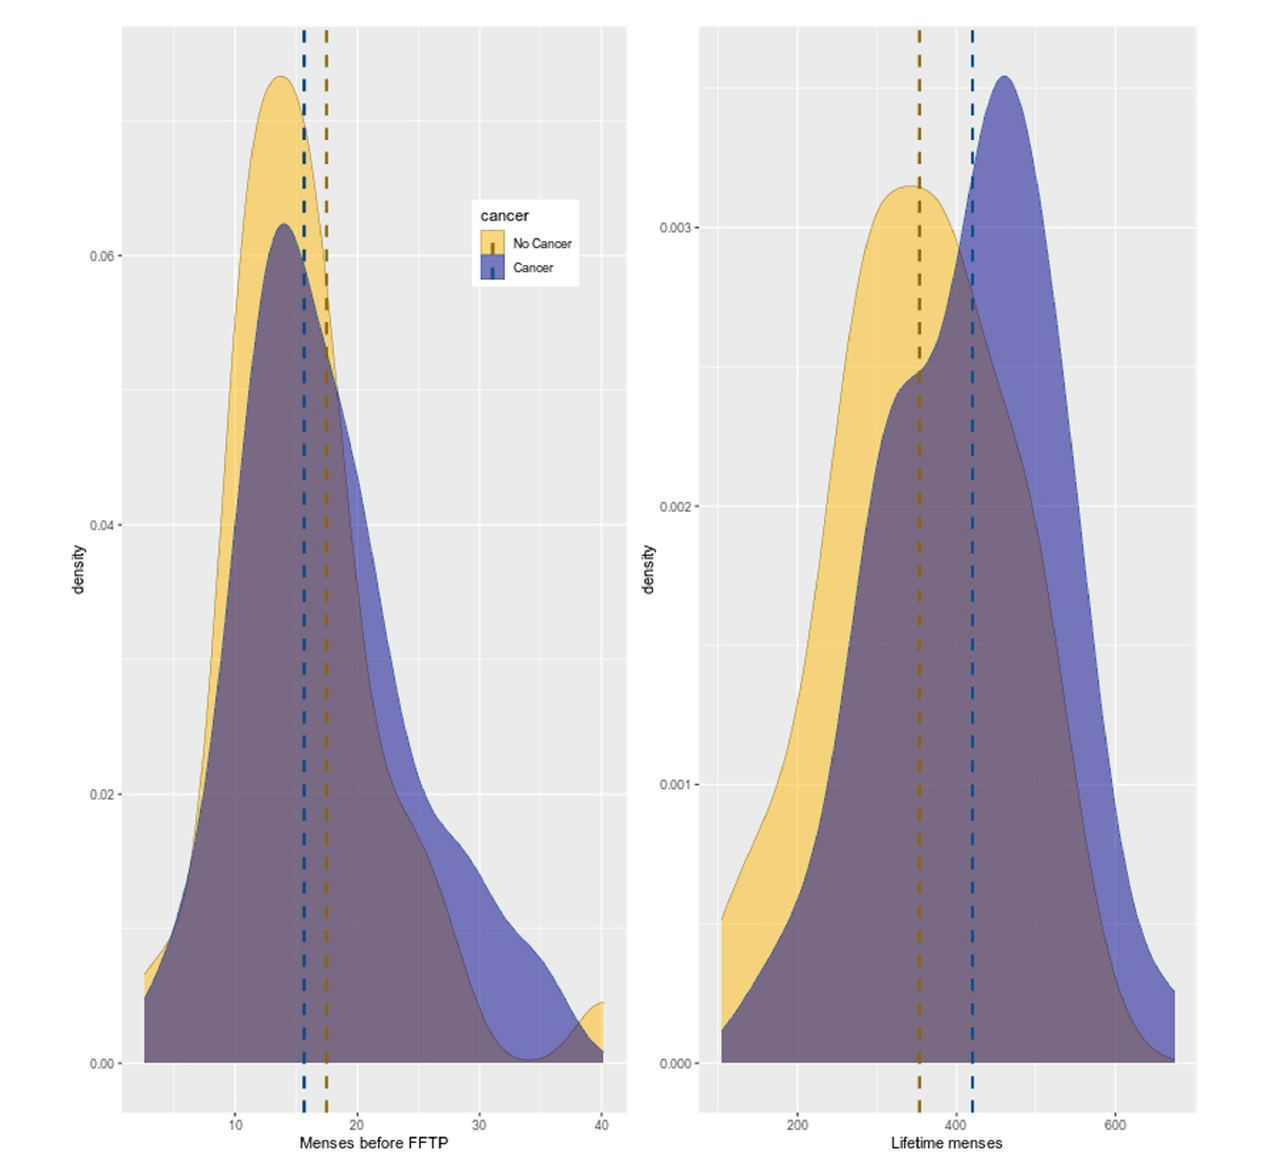
FIGURE 1 Distributions of the number of menses before FFTP and the lifetime number of menses. The distribution of menses before FFTP is similar between cases and controls but distribution of lifetime number of menses is